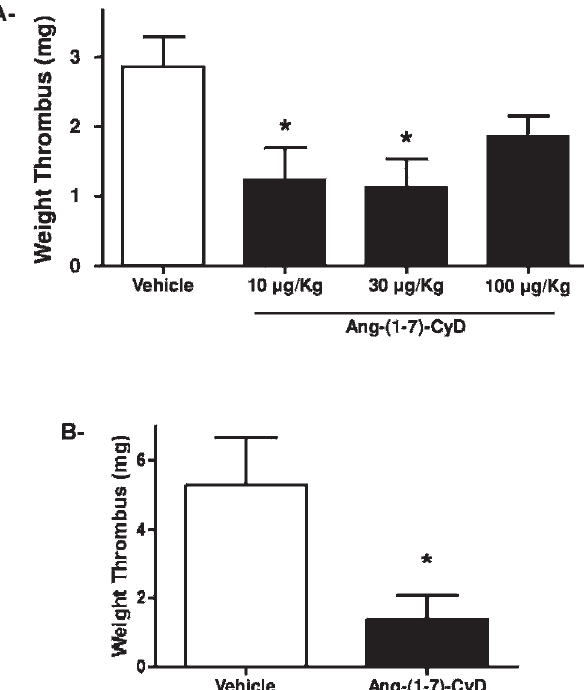
Figure 1 - Ang-(1-7)-CyD promoted antithrombotic effects in SHRs. A) Acute treatment with Ang-(1-7)-CyD (five hours before thrombus induction) inhibited thrombus formation when admi- nistered in doses of the equivalent of 10 m g/kg or 30 m g/kg of Ang-(1-7). B) Chronic administration of Ang-(1-7)-CyD [equiva- lent of 30 m g/kg of Ang-(1-7) per day] over the course of